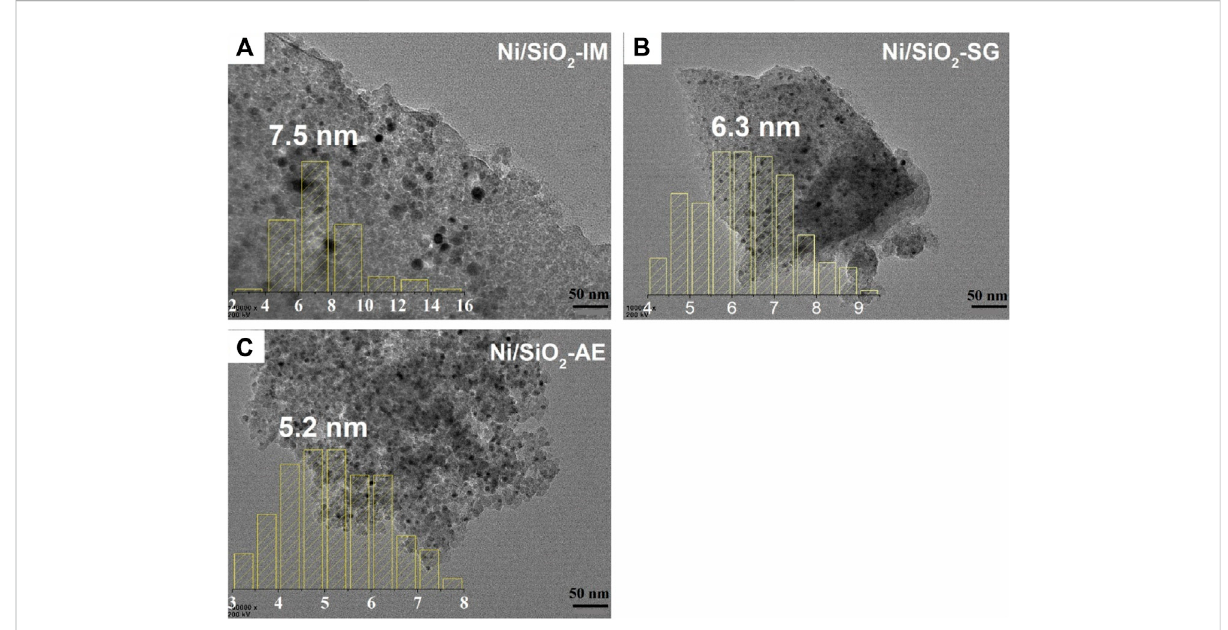
FIGURE 4 The TEM images of reduced Ni-based catalysts. (A) Ni/SiO 2 -IM, (B) Ni/SiO 2 -SG, (C) Ni/SiO 2 -AE.